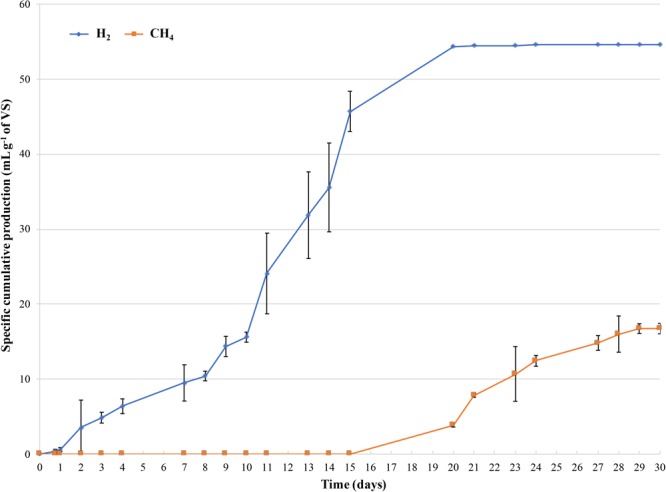
Cumulative specific production of H2 and CH4 monitored during 30 days of incubation. X-axis displays the day, and the Y-axis is the corresponding cumulative H2 or CH4 specific production per gram of the initial concentration of VS of the dairy waste mixture. The error bars represent the means ± SD of two replicates.